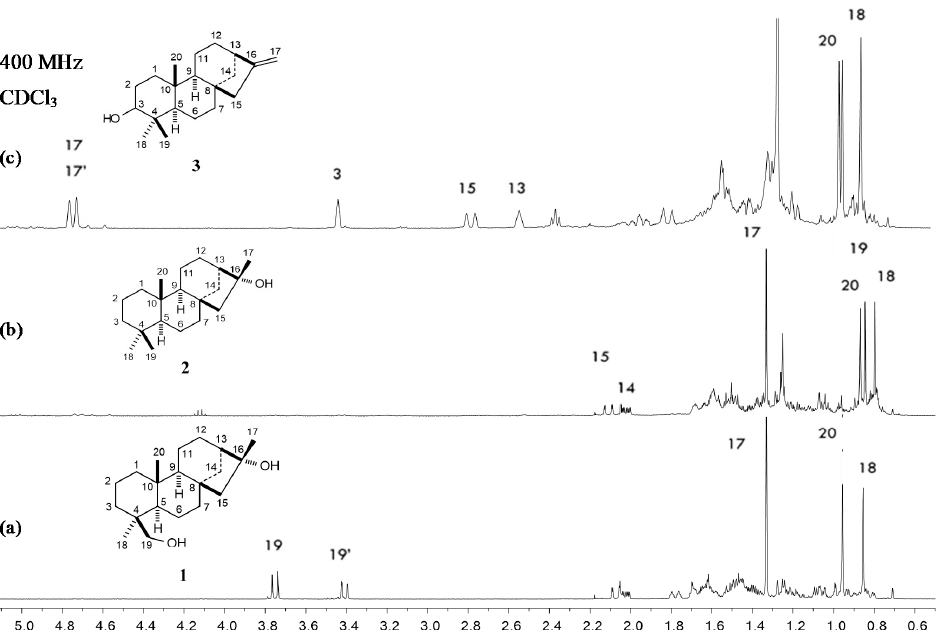
Figure 3. 1 H NMR spectra of phyllocladanes: ( a ) phyllocladan-16 α ,19-diol ( 1 ), ( b ) phyllocladan-16 α -ol ( 2 ), and phylloclad-16-en-3-ol ( 3 ) ( c ). Table 1. 13 C NMR (100 MHz, CDCl 3 ) data of phyllocladanes 1 – 3 . δ C , Position δ C , mult. Position